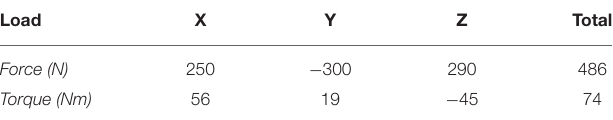
TABLE 4 | Load configuration used for the FEM